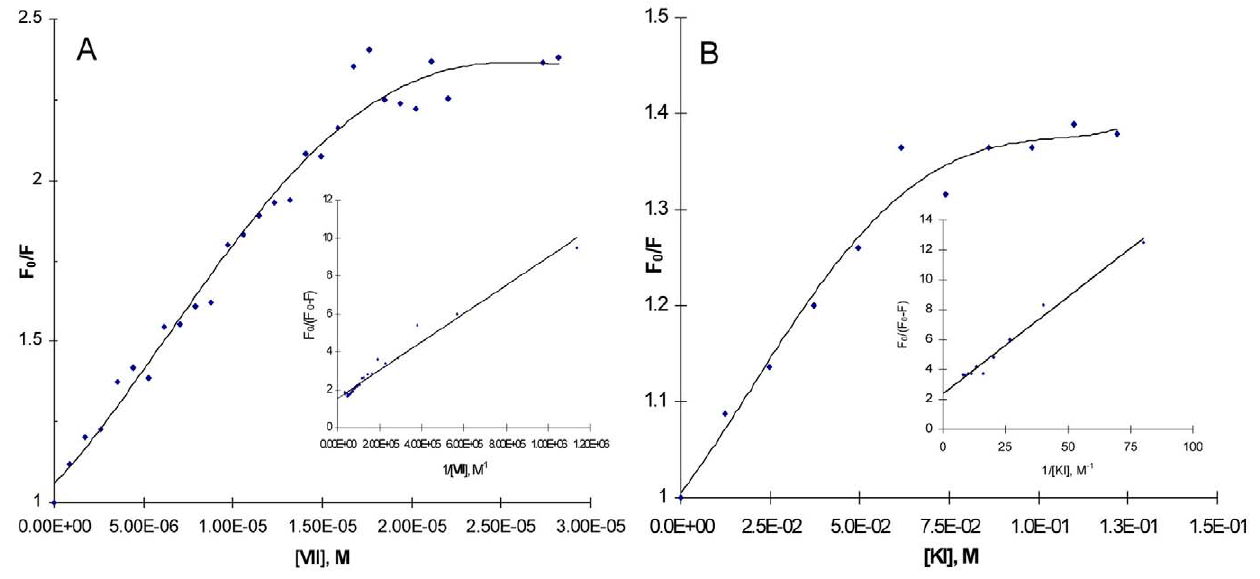
Figure 2. Fluorescence quenching of D DUF Rpf B. A. quenching by (VII). D DUF Rpf B was dissolved in 50 mM phosphate buffer pH 7.5 at concentration 40 m g/ml. Results were shown in the Stern–Volmer plot and in the modified Stern–Volmer plot (insert). Excitation - 280 nm, fluorescence intensity was recordered at 340 nm. Experiment was performed 2 times, with similar results. One experiment is shown. B. quenching by KI. For details see legend to Fig. 2 A . Experiment was performed 2 times, with similar results. One experiment is